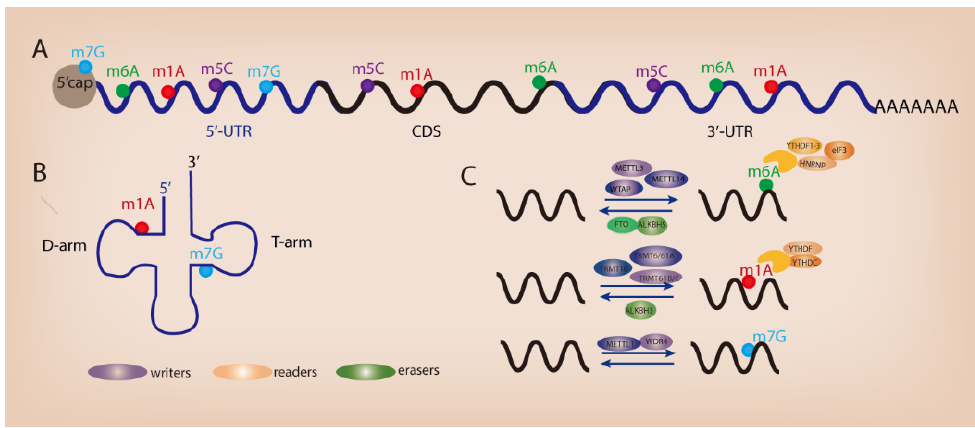
Figure 1. Different types of RNA modifications and their distribution. ( A ) RNA modifications within mRNA. ( B ) RNA modifications in tRNA. ( C ) Regulators of RNA modifications.